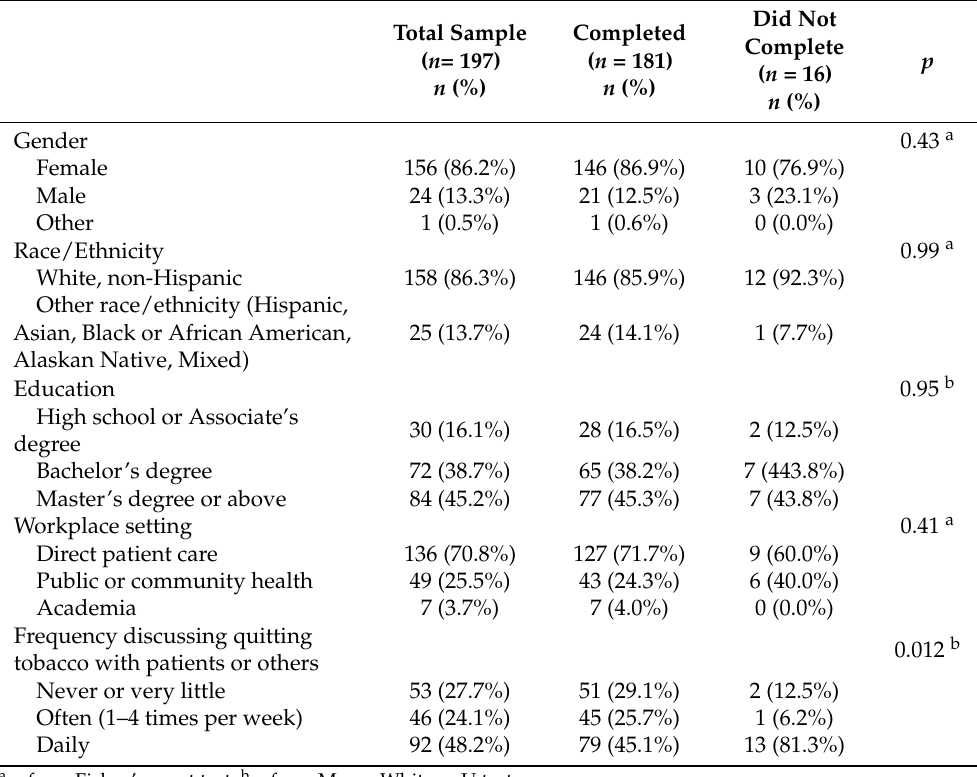
Table 2. Demographics and workplace characteristics by program